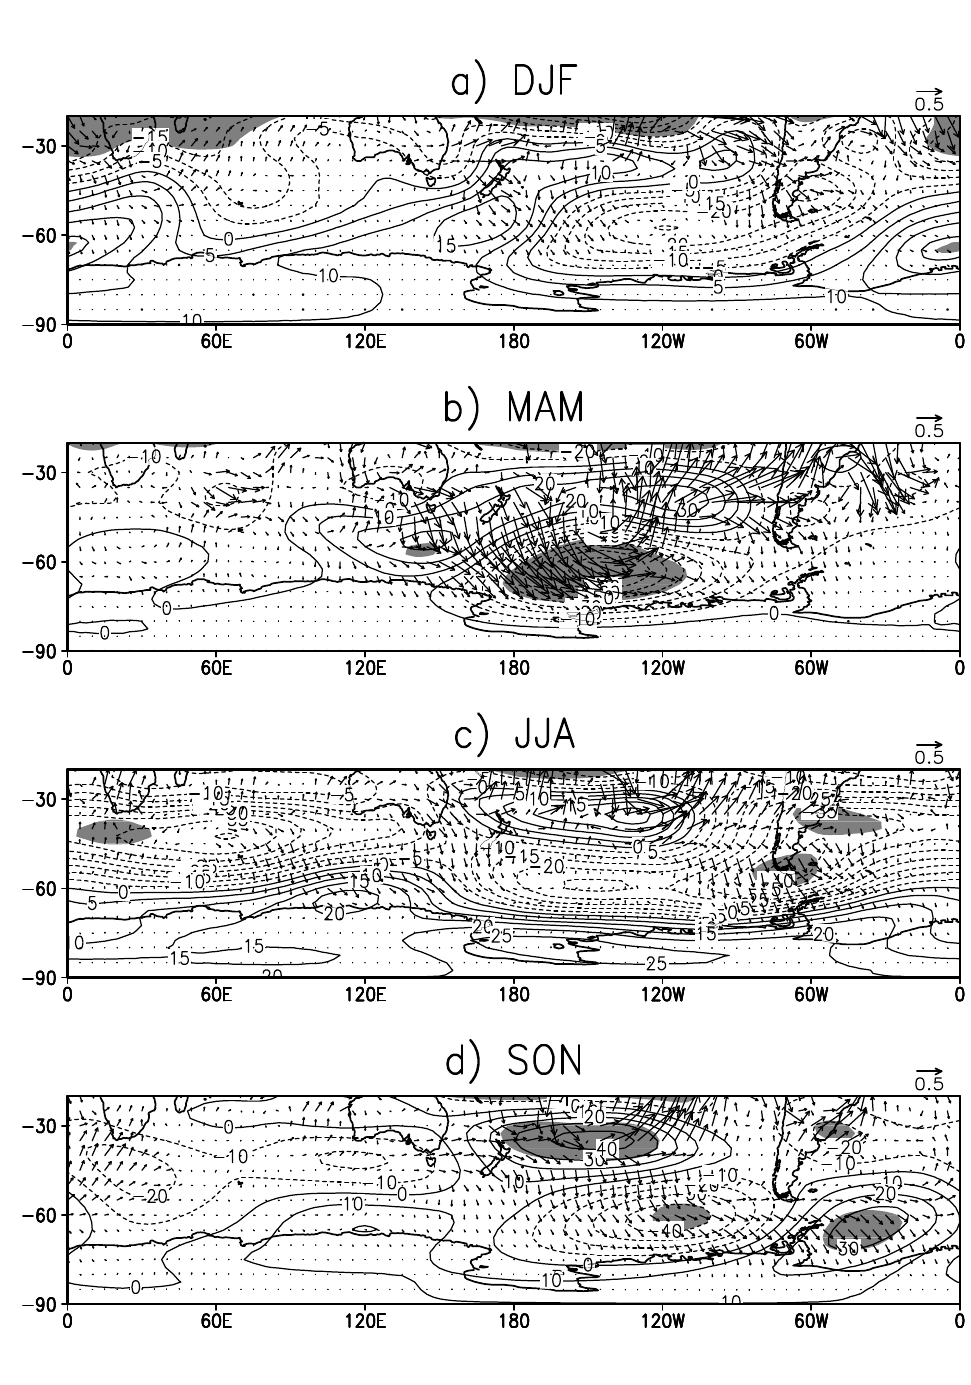
Fig. A4. Same as Fig. A3, but for the La Ni˜na